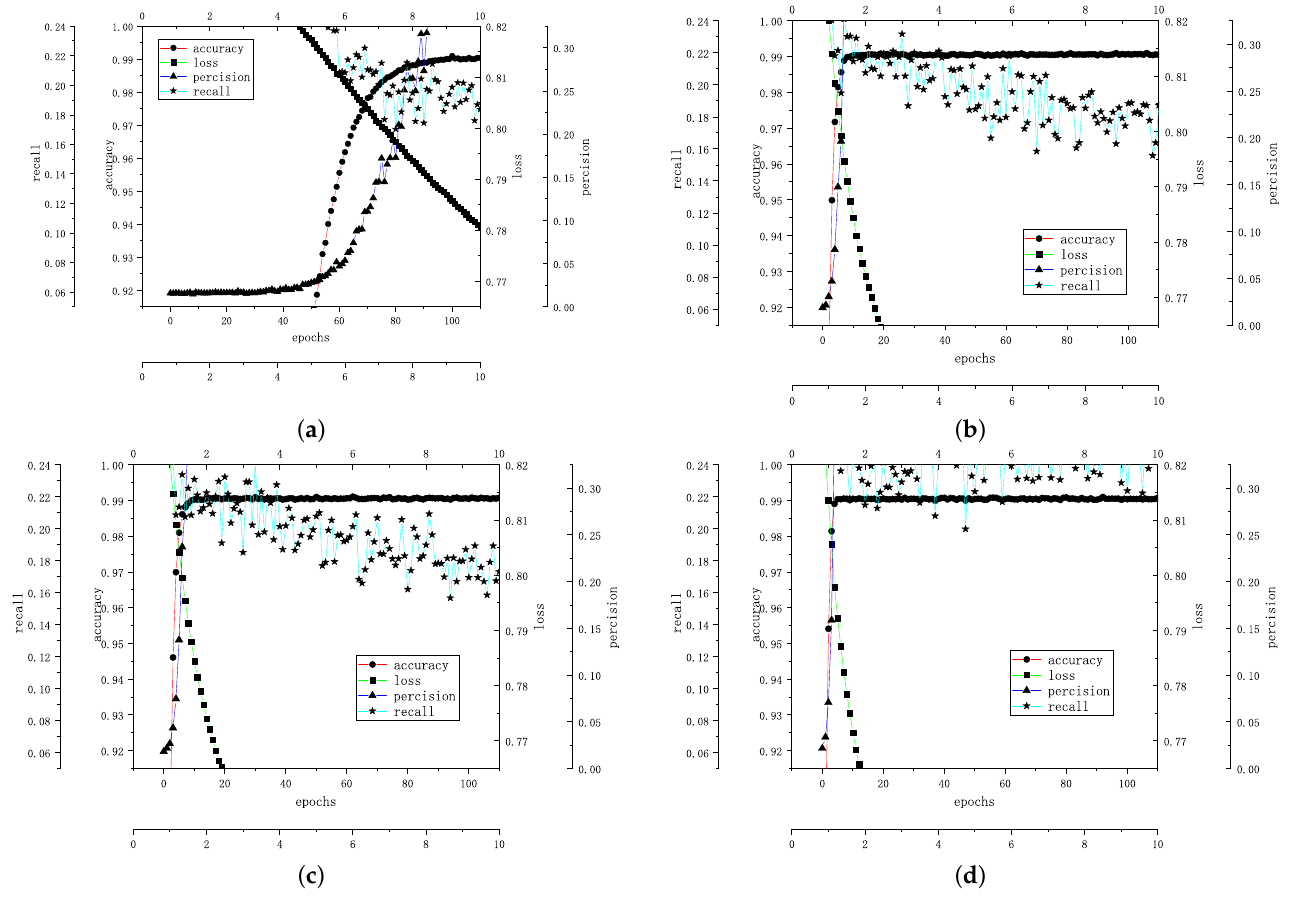
Figure 12. The test dataset evaluation indicators curve of the TP-LSTM-NADE ( a ), 3D-SCN ( b ), BoYa+SCN ( c ), and BoYaTCN ( d ) architecture.